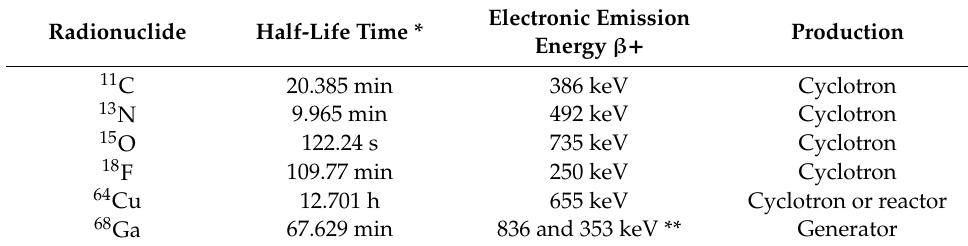
Table 3. Principal radionuclides and related